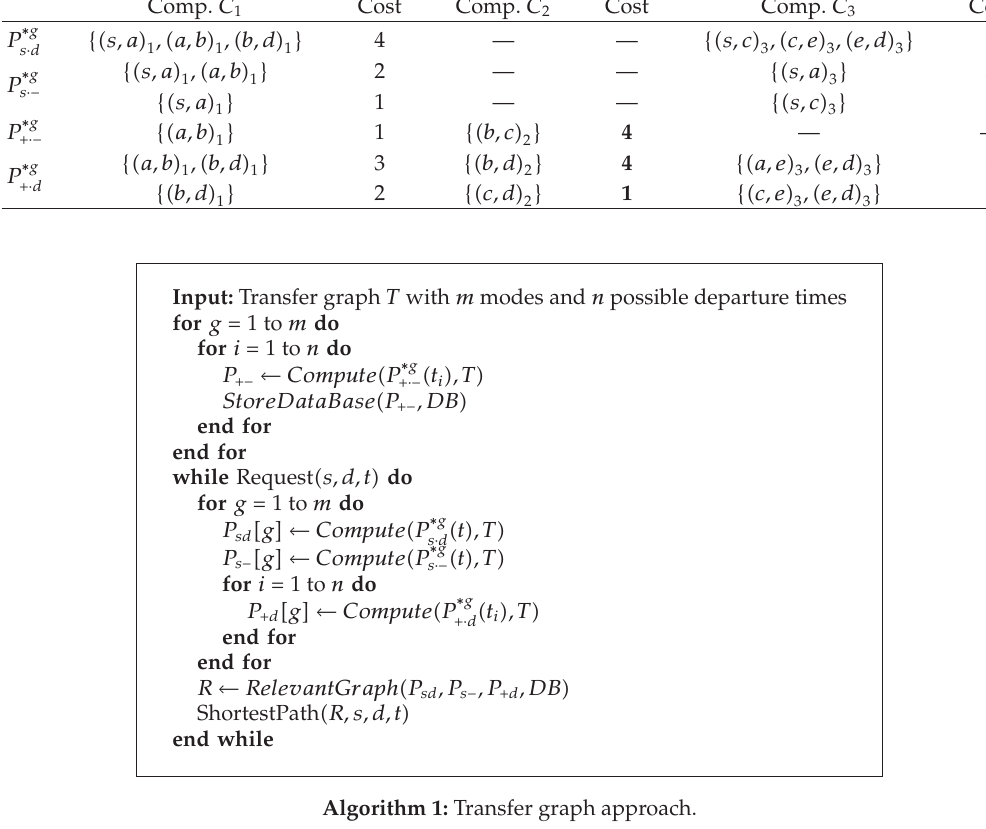
of C 2 increases 2